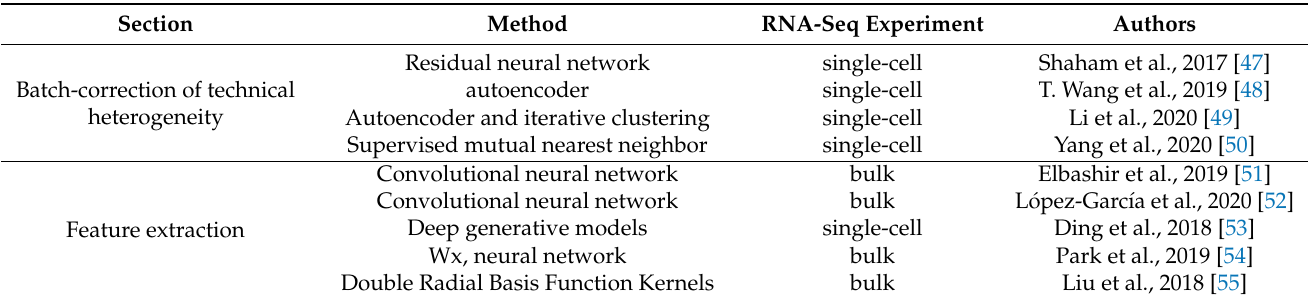
Table 2. The table reports all learning approaches reported in the main text with respect to each section.